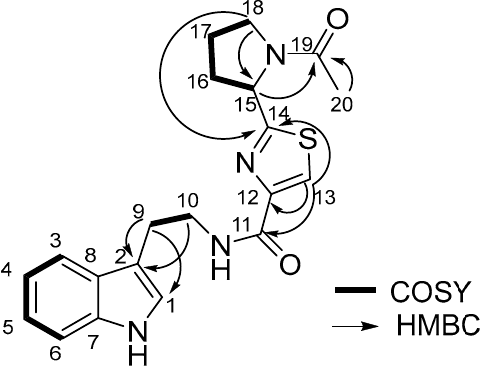
Figure 2. The key 2D NMR correlations of bacillamide F.